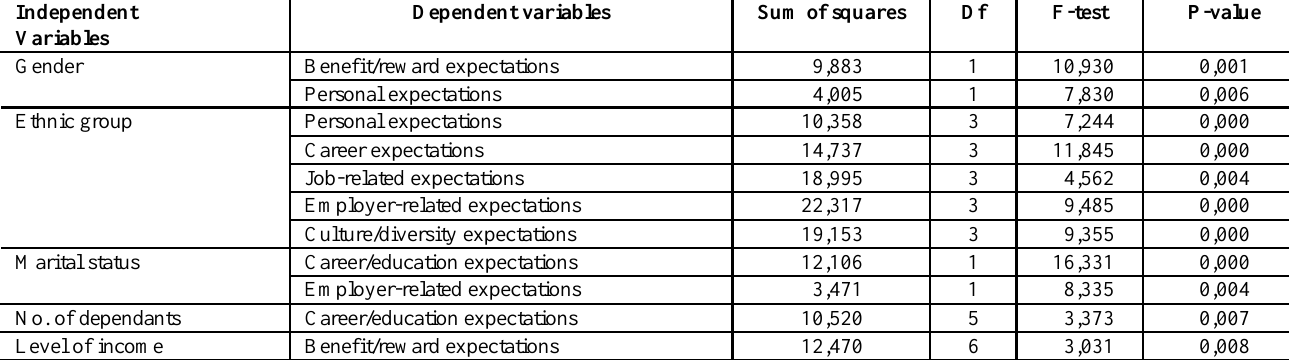
Table 3: Analysis of variance for graduate expectations and the independent variables (classification data)